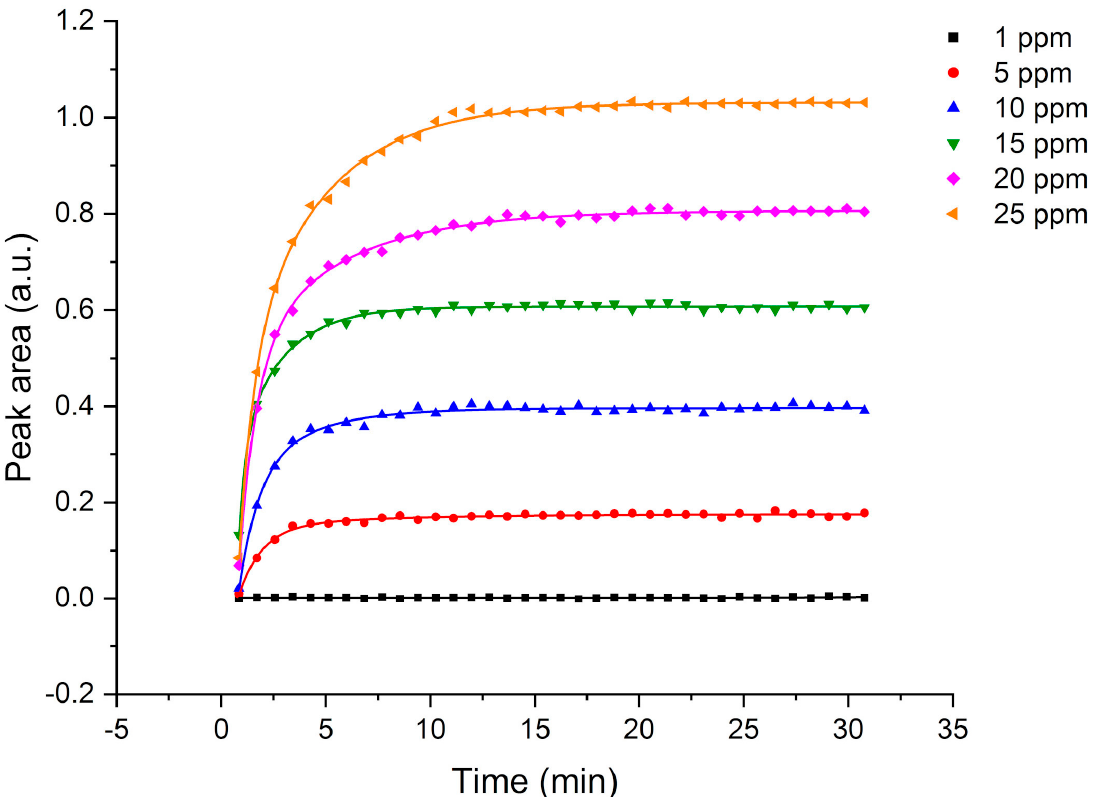
Figure 3. Diffusion curves of TeCE with the concentrations 1 (black), 5 (red), 10 (blue), 15 (green), 20 (pink), and 25 ppm (orange) into E/P-co polymer coated F-DLC Si wafer. The flow rate was set to 8.7 mL/min. The data points were fitted using an exponential fit function. Table 1. Coe ffi cients for exponential fitting the enrichment functions and t 90 -value of TeCE into E / P-co polymer membrane at the concentrations 1, 5, 10, 15, 20, and 25 ppm a . Concentration